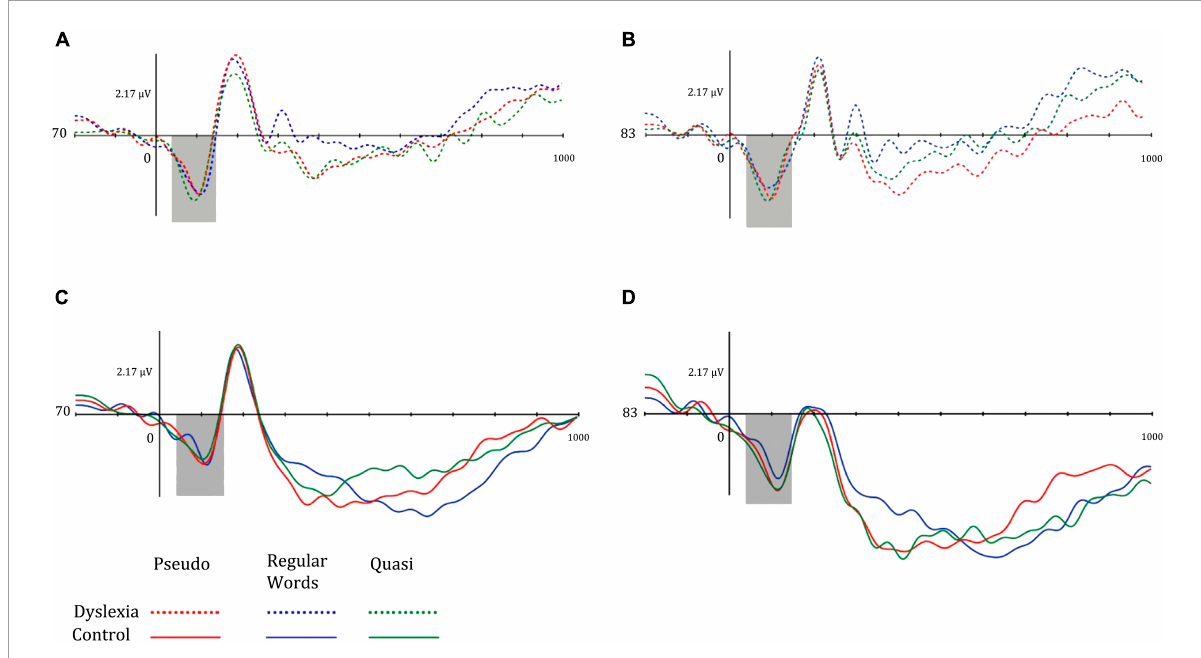
FIGURE3 Mean amplitude of the P100 component for (A) dyslexia group and left hemisphere, (B) dyslexia group and right hemisphere, (C) control group and left hemisphere, and (D) control group and right hemisphere. Dotted lines represent the dyslexia group, while solid lines represent the control group. Red-colored lines represent pseudo words, blue-colored lines represent regular words, and green-colored lines represent Quasi words.